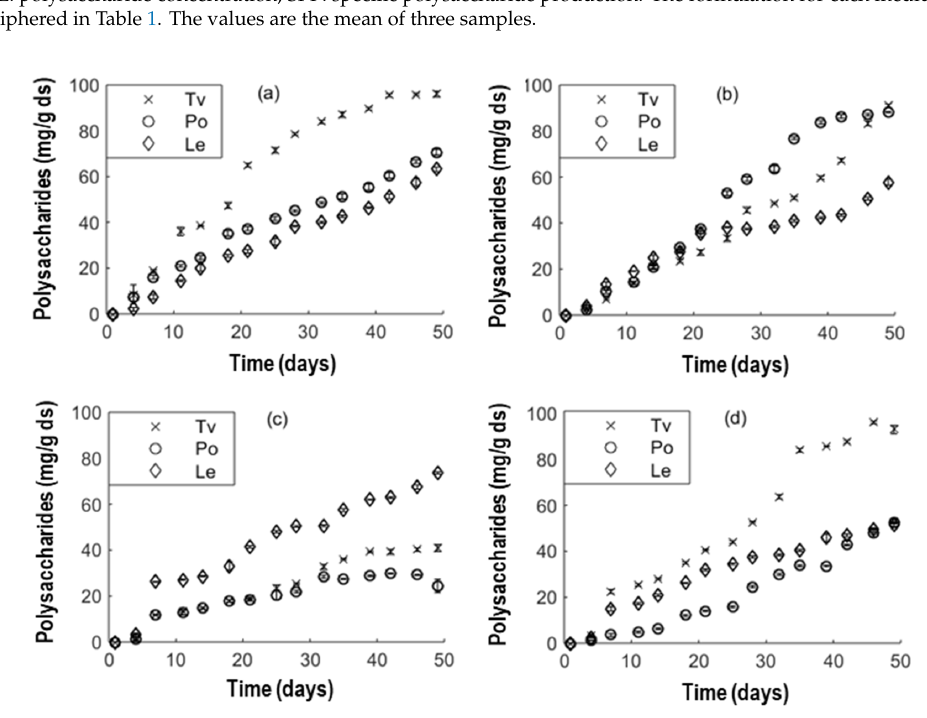
POL: polysaccharide concentration; SPP: specific polysaccharide production. The formulation for each medium is deciphered in Table 1. The values are the mean of three samples.